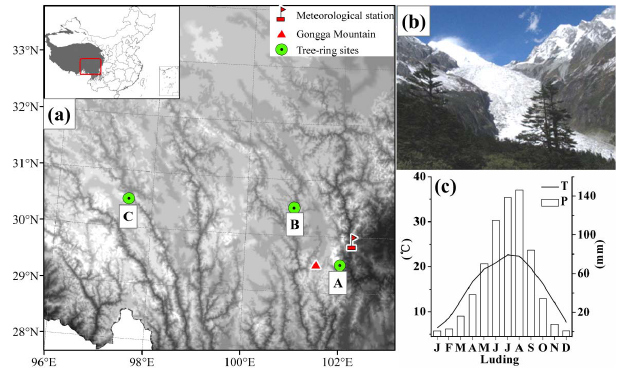
Fig. 1. (a) Location map showing the tree-ring sites and meteoro- logical station. Letters A, B, and C are locations of the tree-ring sampling site in this study, tree-ring-based temperature reconstruc- tions from west Sichuan Plateau (Shao and Fan, 1999) and eastern Tibet (Wang et al., 2010), respectively. (b) A picture of the study area. (c) Monthly mean temperature and monthly total precipitation in Luding meteorological station during